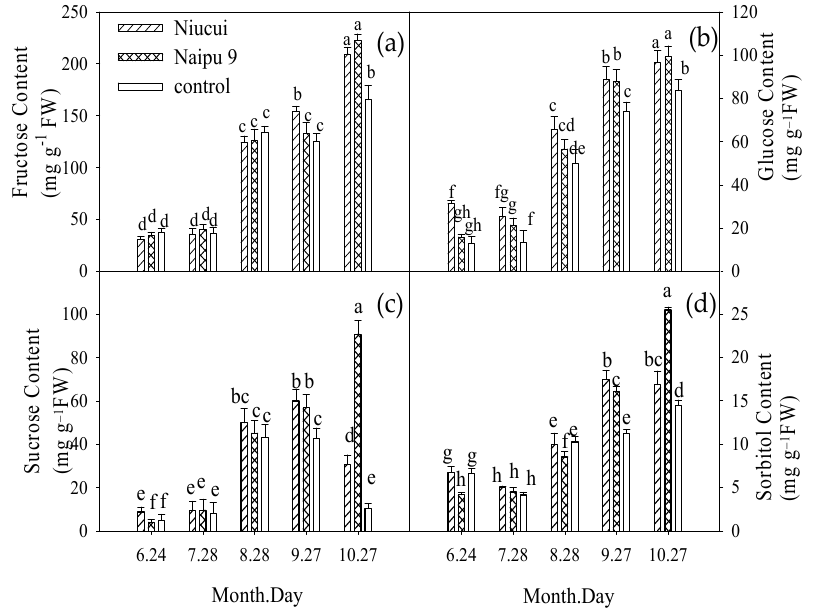
Figure 2. Effects of spraying calcium fertilizer on the contents of ( a ) fructose, ( b ) glucose, ( c ) sucrose, and ( d ) sorbitol in apple fruit. The values are mean ± S.E. of three replicates. Bars represent S.E. Bars with the same letter were not significantly different at p < 0.05.